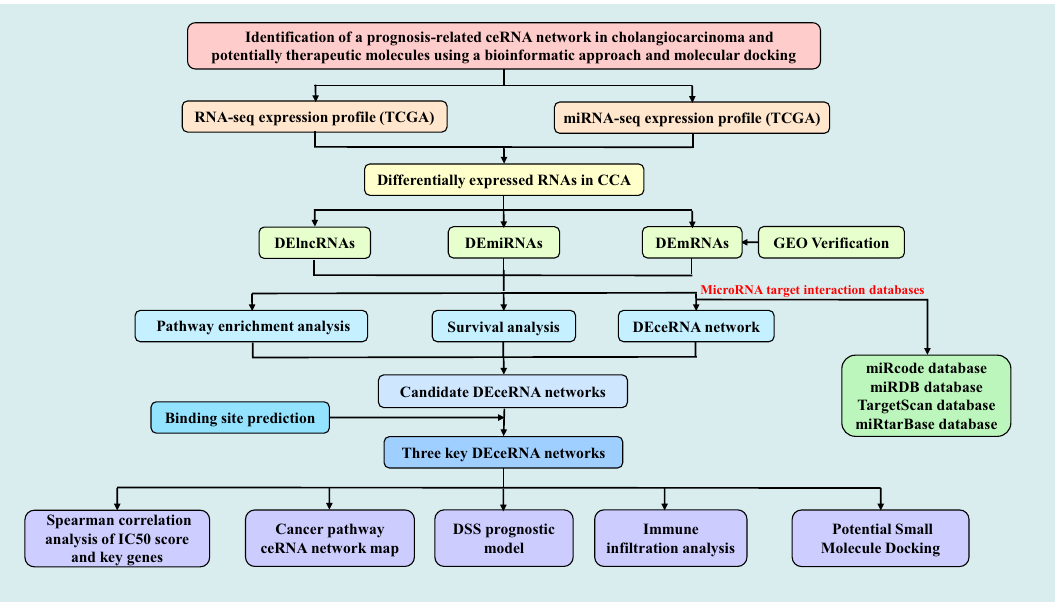
Figure 1. Flow chart of the methodology of the